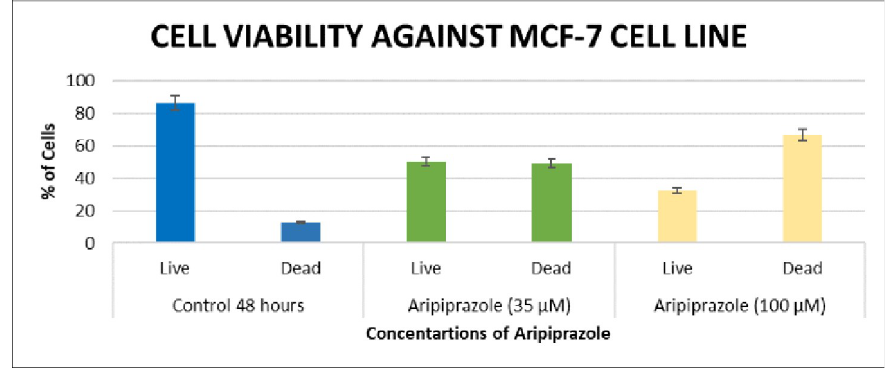
Fig 3. Graphical representation of percent inhibition of MCF 7 cell line in cell viability assay. Percentages of live and dead cells in control group (blue), in presence of aripiprazole 35 μ M (green) and 100 μ M